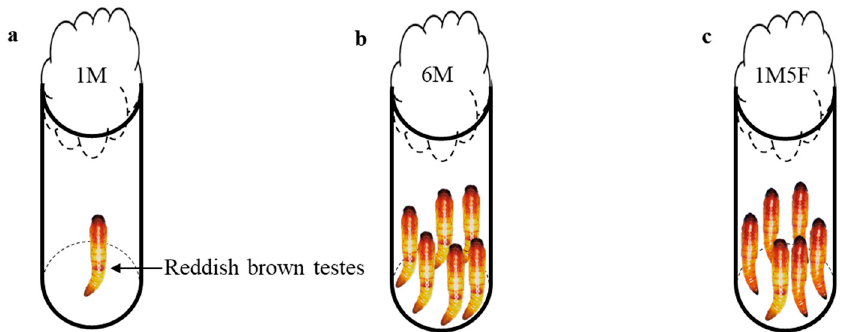
Figure 1. Experimental setup for the entire pupal stage of E. kuehniella : ( a ) 1M, one male, ( b ) 6M, six males together, and ( c ) 1M5F, one male and five females together.